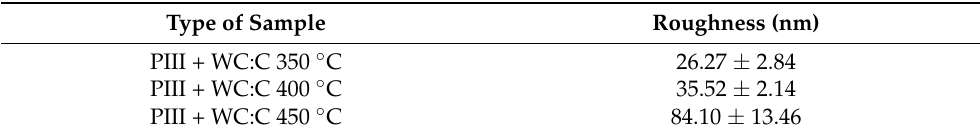
Table 6. Sa roughness measurements for PIII + WC:C 350 ◦ C, PIII + WC:C 400 ◦ C and PIII + WC:C 450 ◦